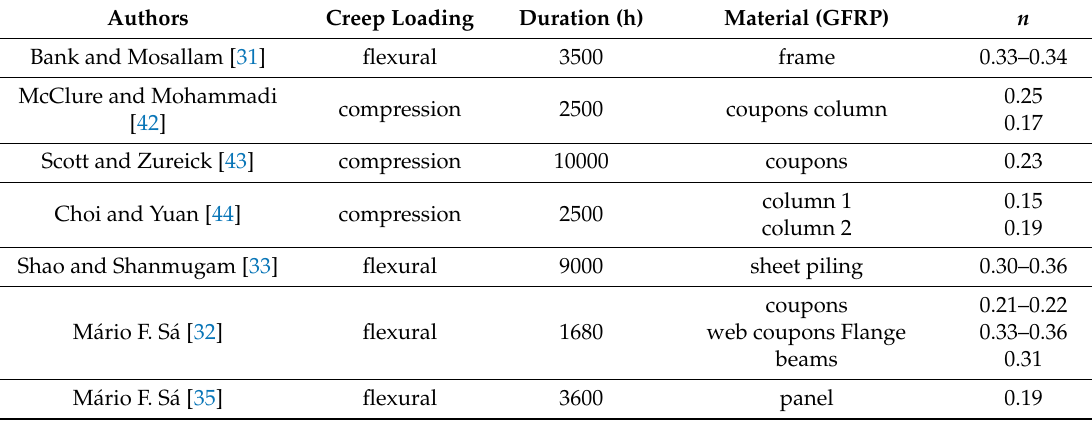
Table 4. Average values for material constant n obtained from di ff erent creep studies. GFRP, glass–fiber-reinforced polymer